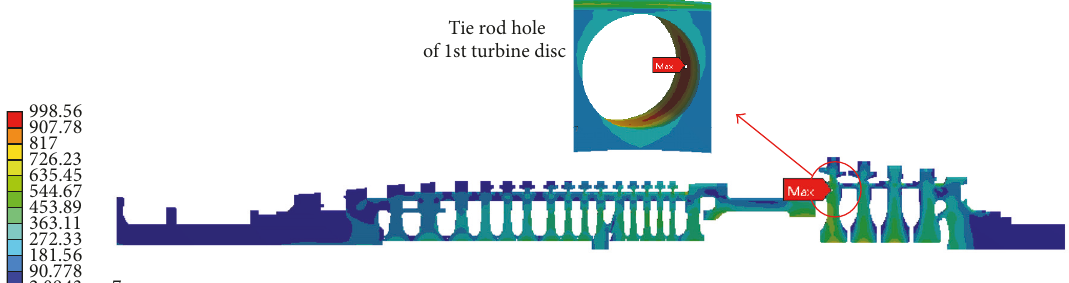
Figure 13: Equivalent stress distribution of the rotor at time of 600 s/MPa.